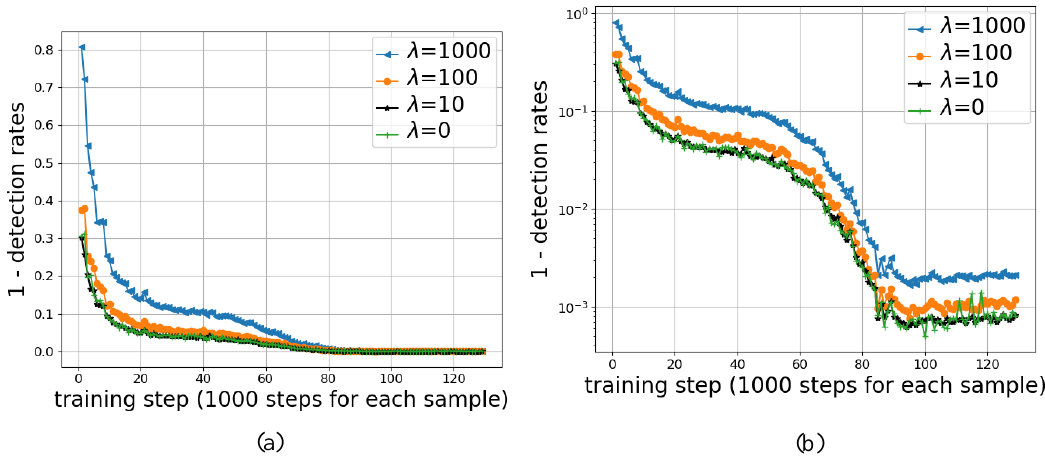
Figure 5. The training processes with different regularization. ( a ) (1 – detection rate) during training processes; ( b ) log 10 (1 – detection rate) during training processes.